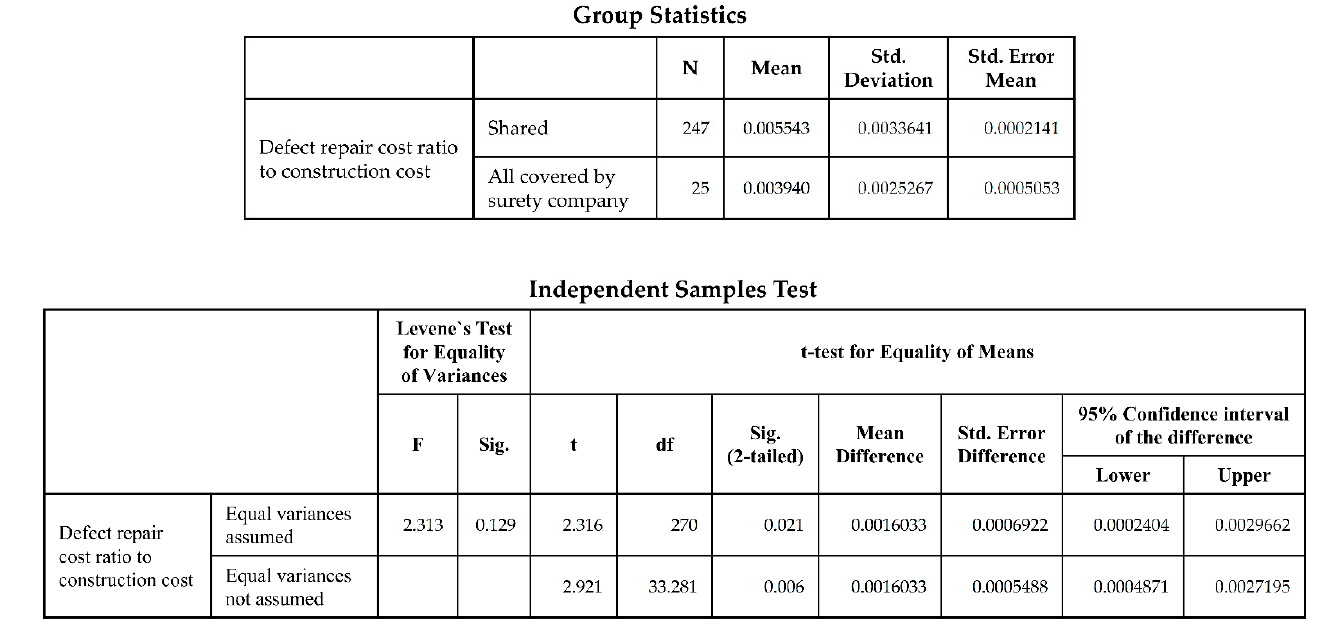
Figure A9. t -test result of additional damage sharing to the warranty Figure A9. t ‐ test result of additional damage sharing to the warranty company.